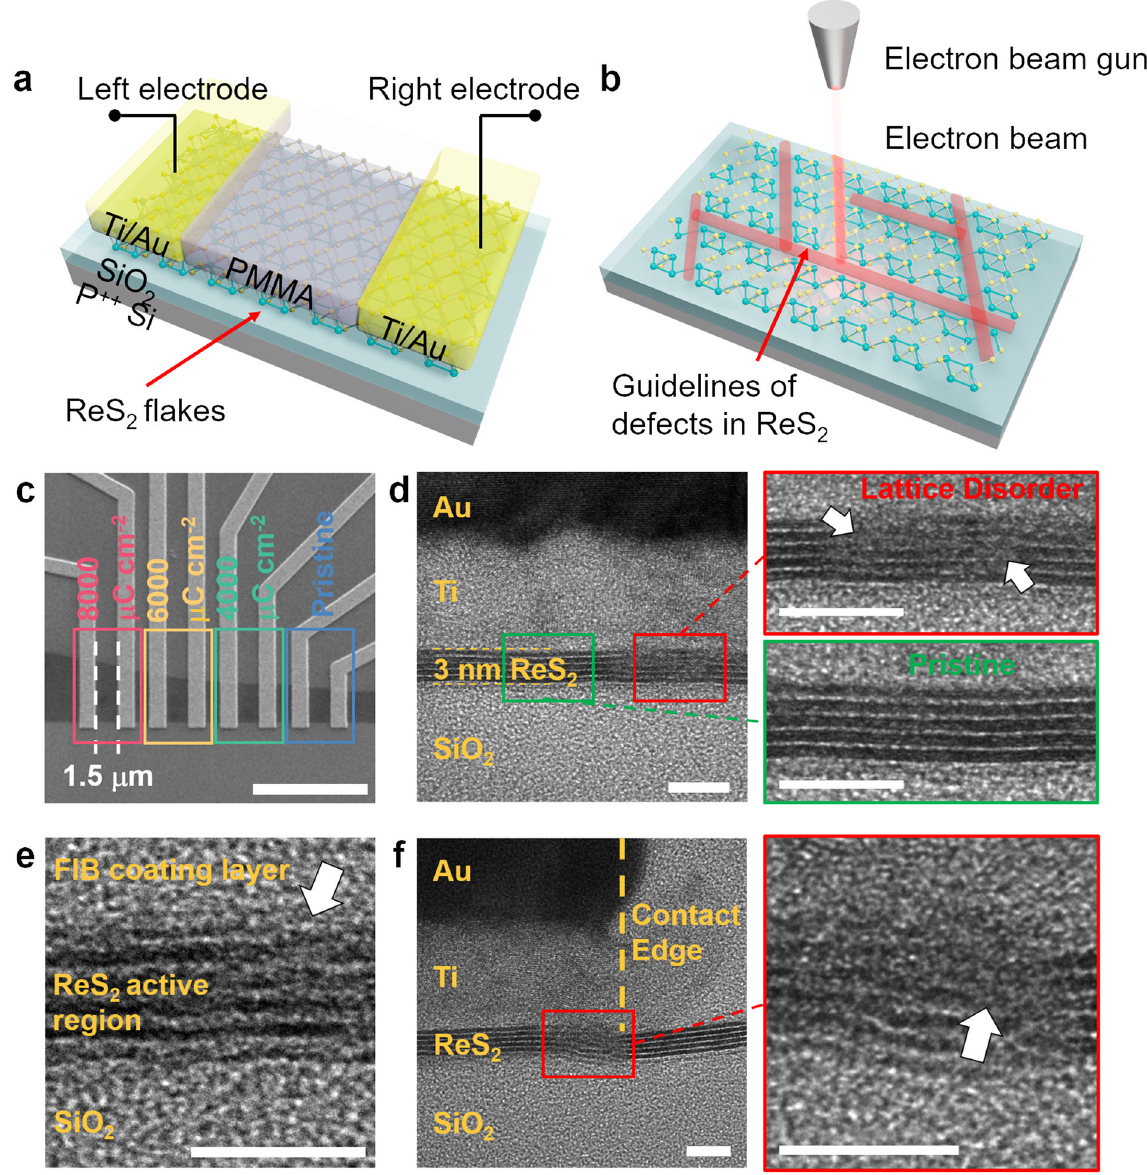
Fig. 1 Structure of ReS 2 memristor. a A structural schematic of our ReS 2 planar memristor. b A schematic illustration of EBI. Selective area irradiation was performed by focused electron beam. The red lines in ReS 2 show the guidelines of defects. c SEM image of ReS 2 memristors. The distance between two electrodes is 1.5 μ m. The highlighted squares show the irradiation dosage and regions. Scale bar, 5 μ m. d – f Cross- section TEM images of a ReS 2 memristor under 6000 μ C cm − 2 EBI. d At contact region. Insets show zoom-in images of lattice disorder (red) and pristine crystal structure (green). The white arrows show position of lattice disorders. Scale bar, 5 nm. e At ReS 2 active region. Scale bar, 5 nm. f At contact edge. The yellow dashed line labels the contact edge position. Inset shows the zoom-in image of lattice disorders (red). Scale bar, 5